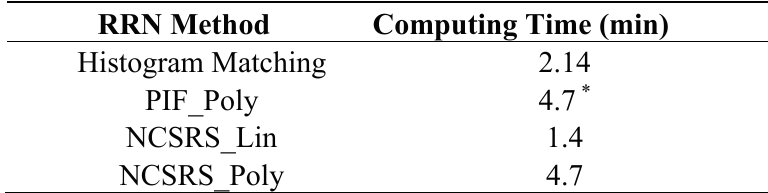
Table 2. Computation time of four different relative radiometric normalization (RRN) methods evaluated in this